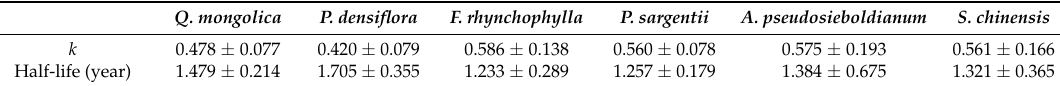
Figure 1. Change in branch wood disk mass of six tree species during a decomposition period of 40 months. Bars indicate SD ( n = 5). Table 3. Morphological properties of branch wood disk samples for six tree species. Values are means ( n = 5) ± SD.